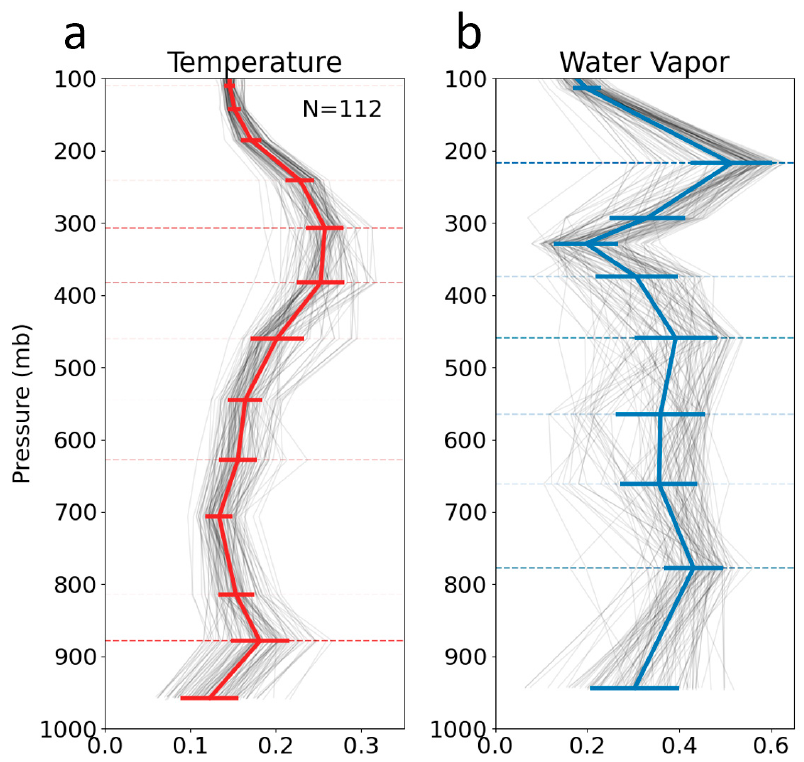
Figure 5. Mean averaging kernel diagonals for ( a ) temperature and ( b ) water vapor retrievals where the IR + MW retrieval was successful (112 profiles). Thin black lines show the individual profiles, while thicker lines are the average. Solid horizontal lines are the standard deviation. Thinner dashed lines are local maxima or peaks of the individual profiles. Dashed lines are darker where more profiles peaked.